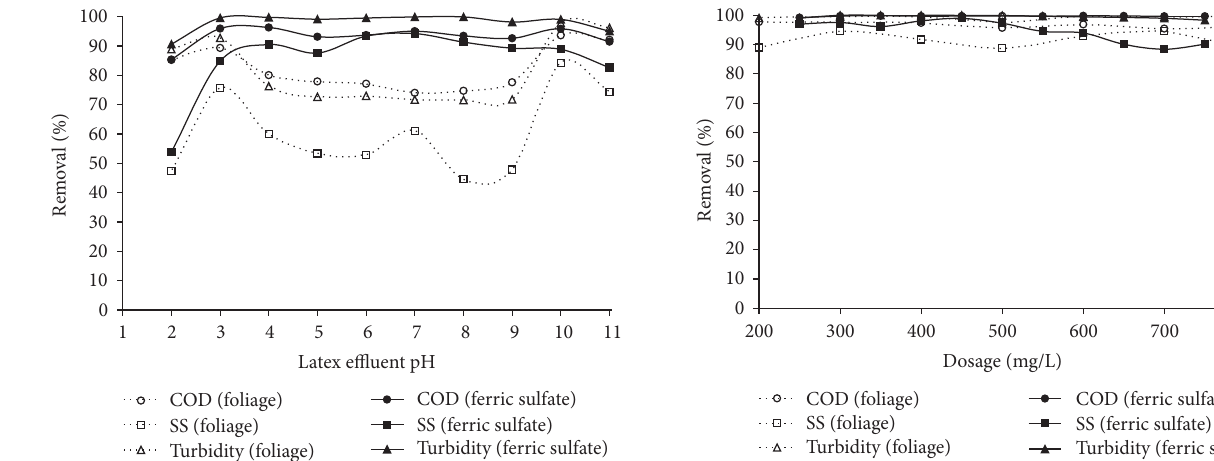
F 3: Effect of latex effluent pH on coagulation effectiveness at coagulant dosage 500mg/L.